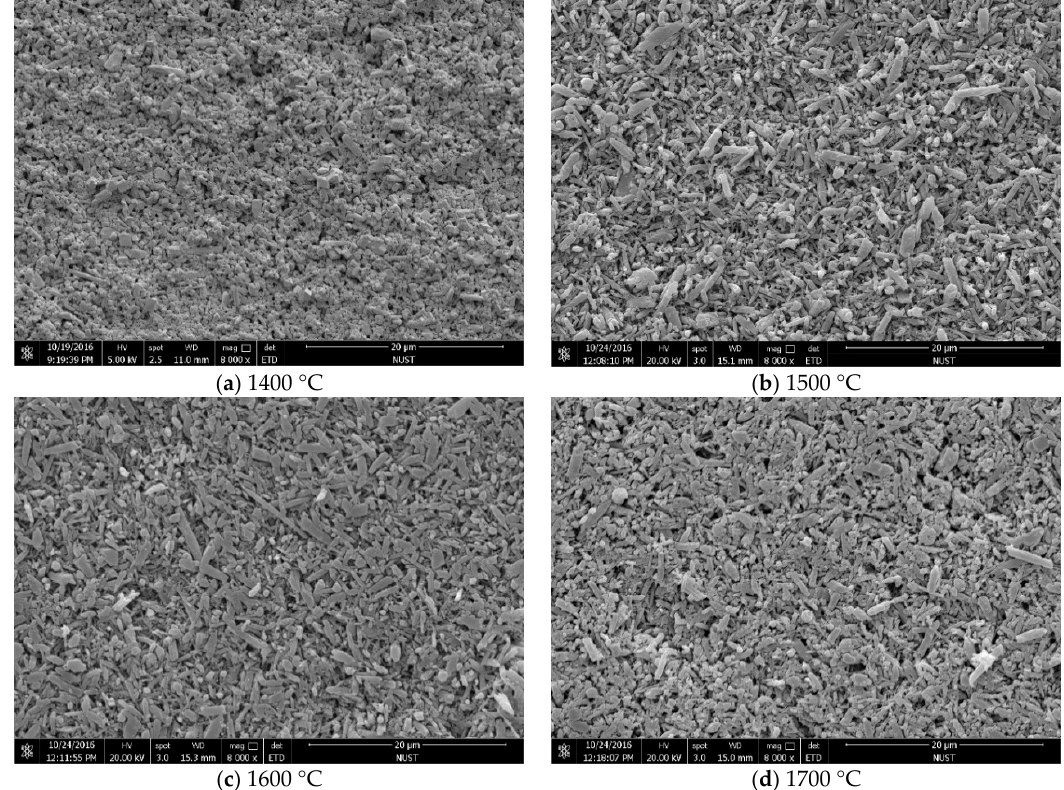
Figure 4. SEM micrographs of the fracture surface morphology of the samples after molten NaOH corrosion at different sintering temperatures (holding time for 10 min).